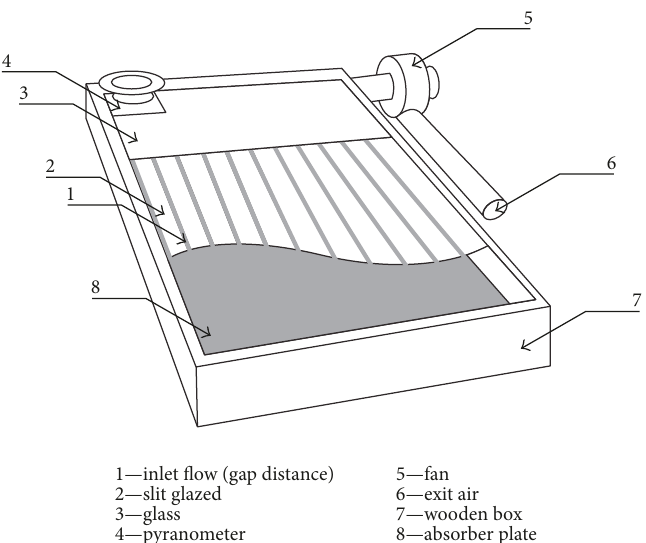
Figure 1: Schematic view of the slit-glazed collector